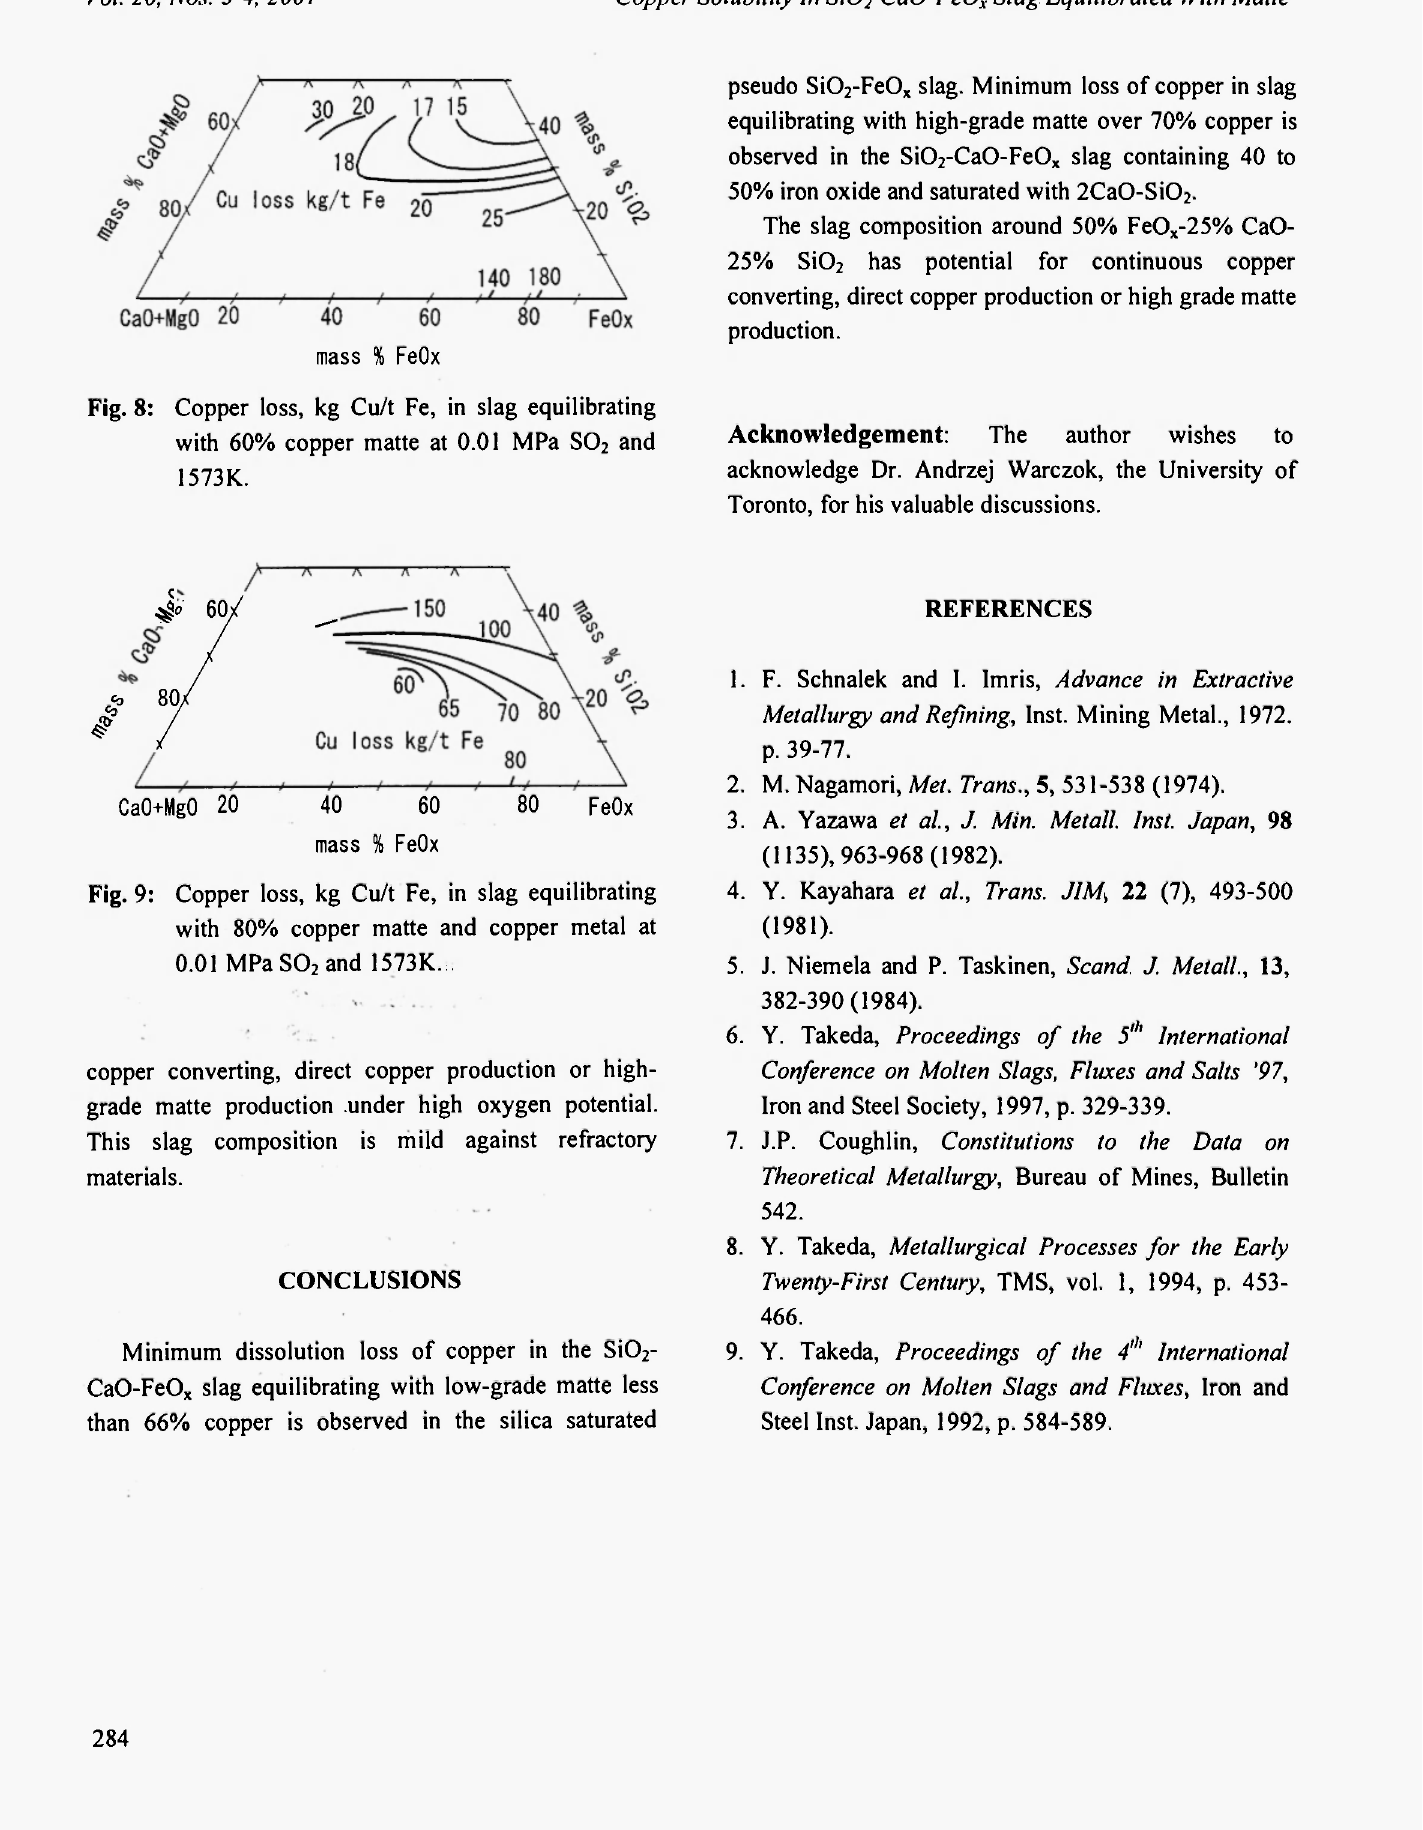
Fig. 8: Copper loss, kg Cu/t Fe, in slag equilibrating with 60% copper matte at 0.01 Μ Pa S0 2 and 1573K.